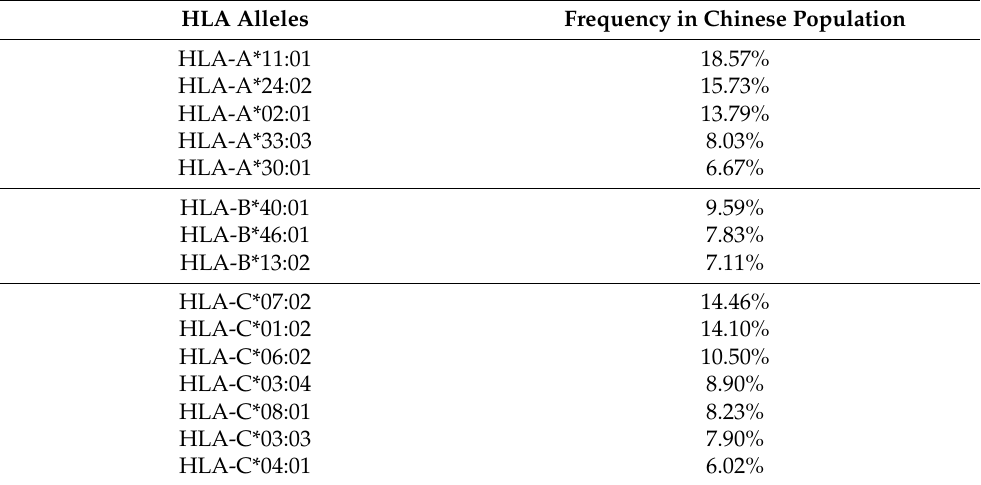
Table 1. The frequency of human leukocyte antigens (HLA) alleles among the Chinese population. HLA